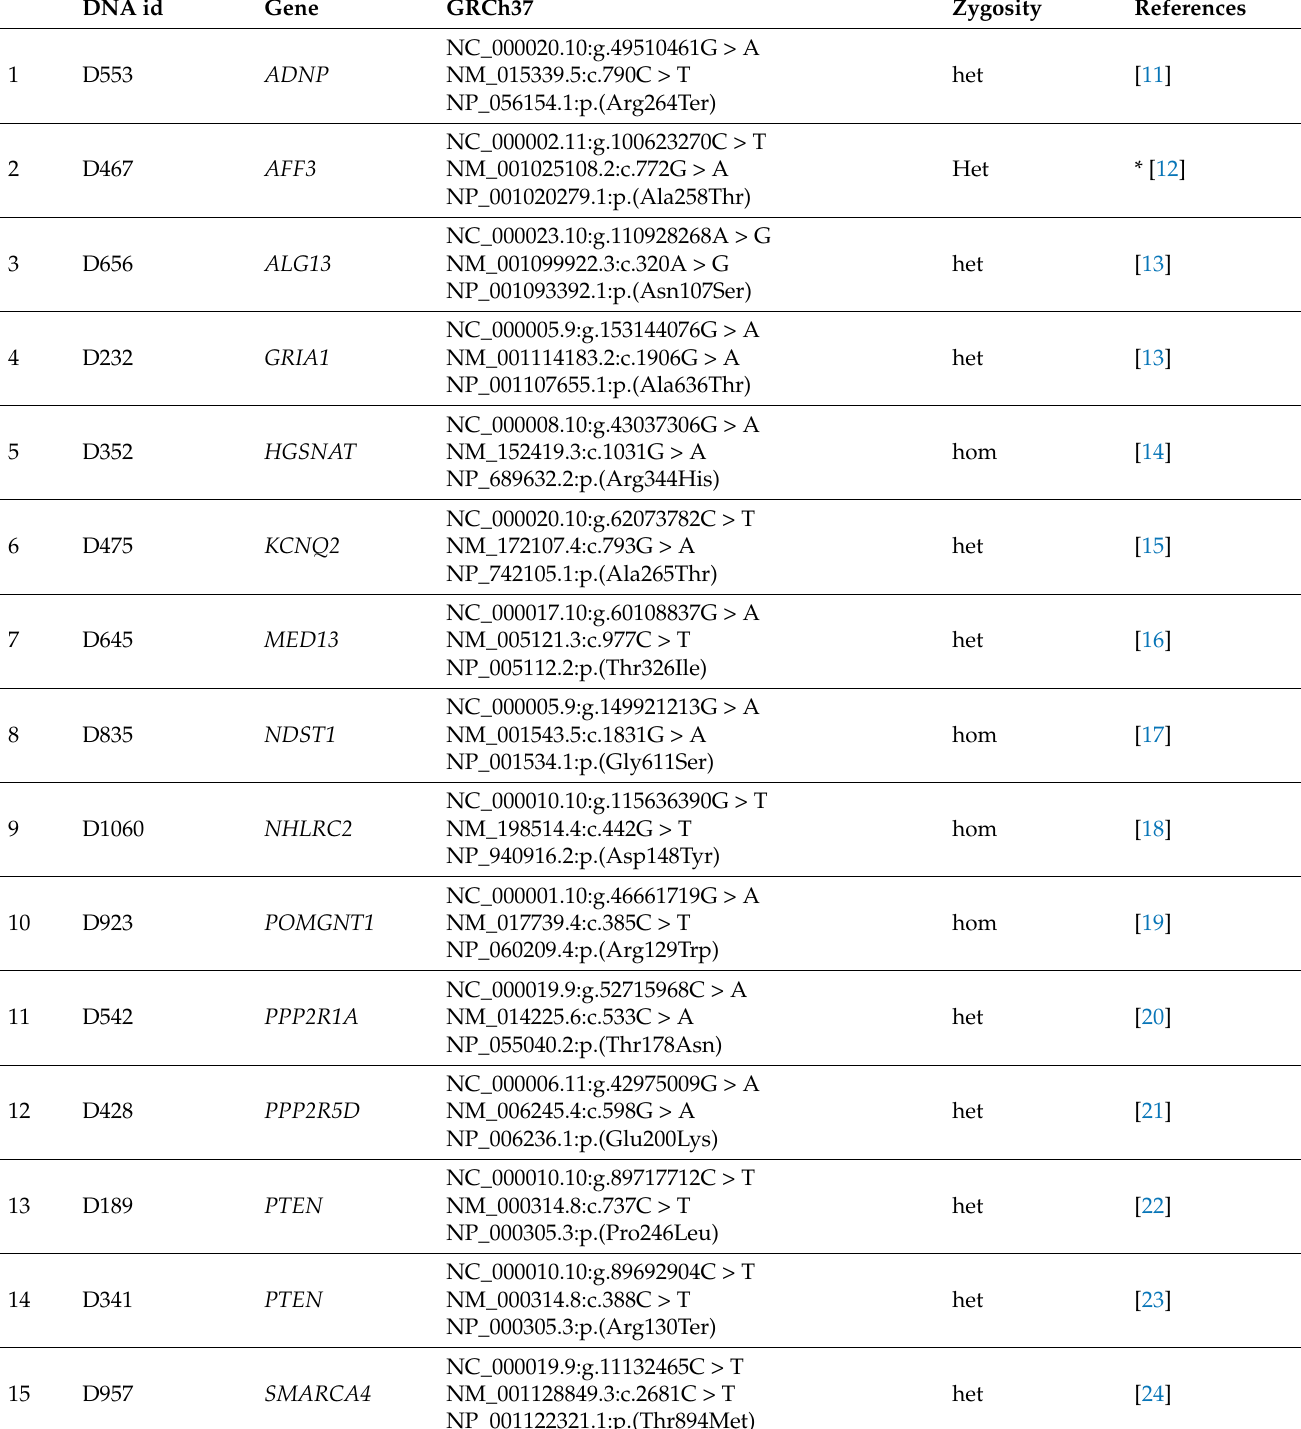
Table 1. Variants classified in HGMD as